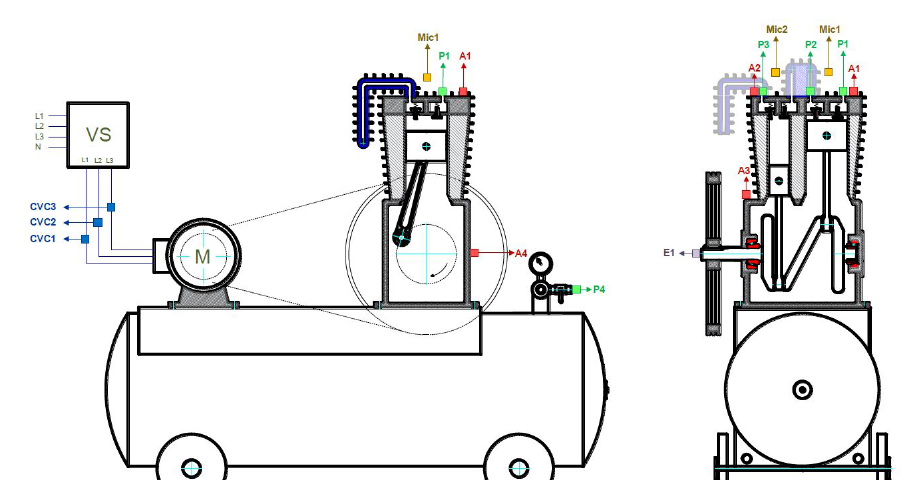
Figure 2. Sensors’ locations in the RC. The accelerometers are denoted as A1, A2, A3, and